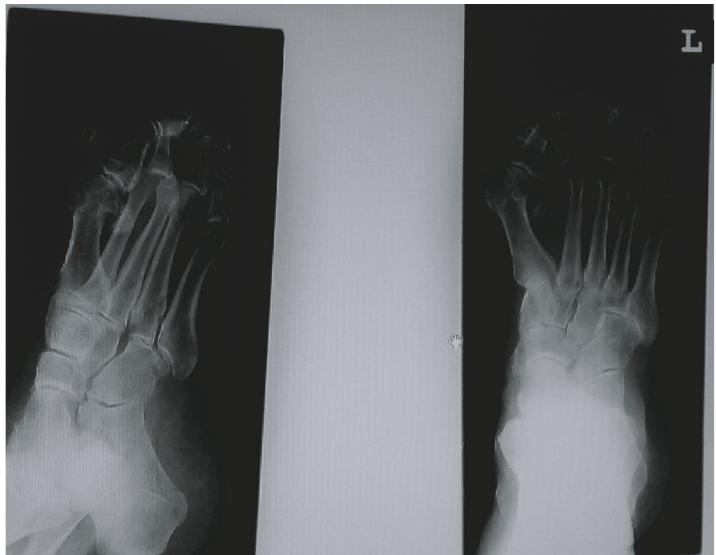
Figure 2: X-ray of the patient ’ s left foot before the operation.